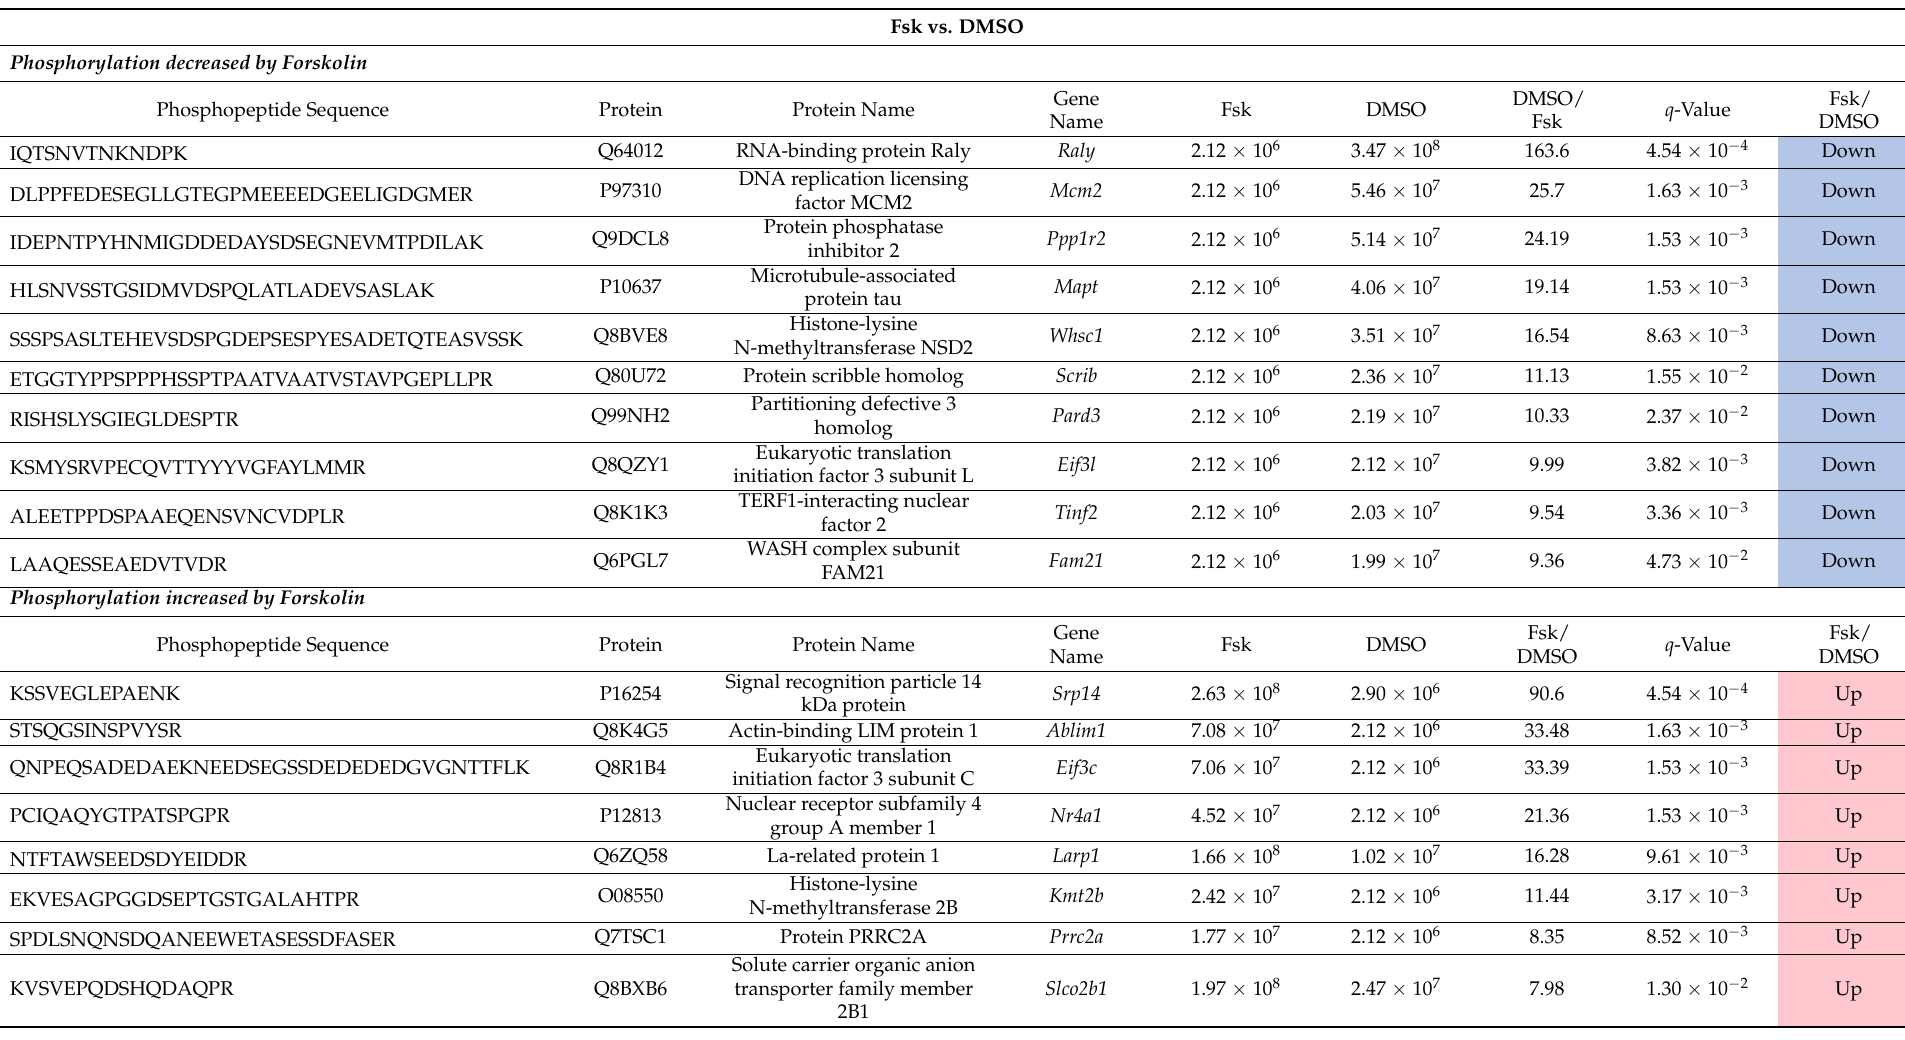
Table 2. Top 10 phosphopeptides differentially phosphorylated in MA-10 Leydig cells treated with vehicle (DMS), Fsk, or Fsk+AICAR (pair comparisons). Fsk vs.